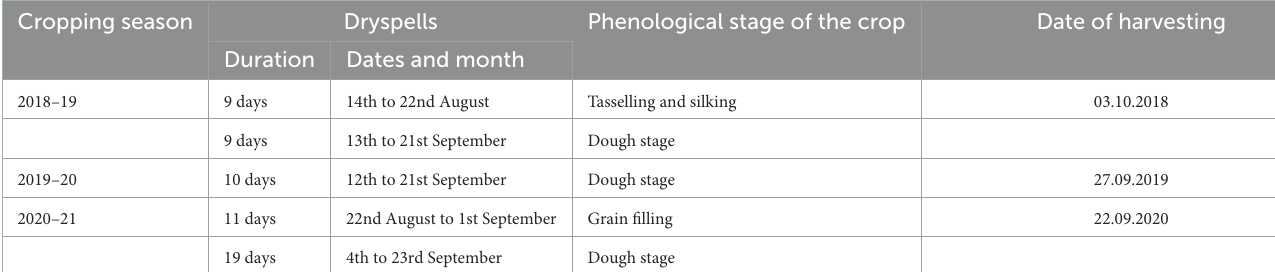
TABLE 2 Dryspells observed during three cropping seasons (2018–20) at Ballowal Saunkhri (Punjab). Cropping